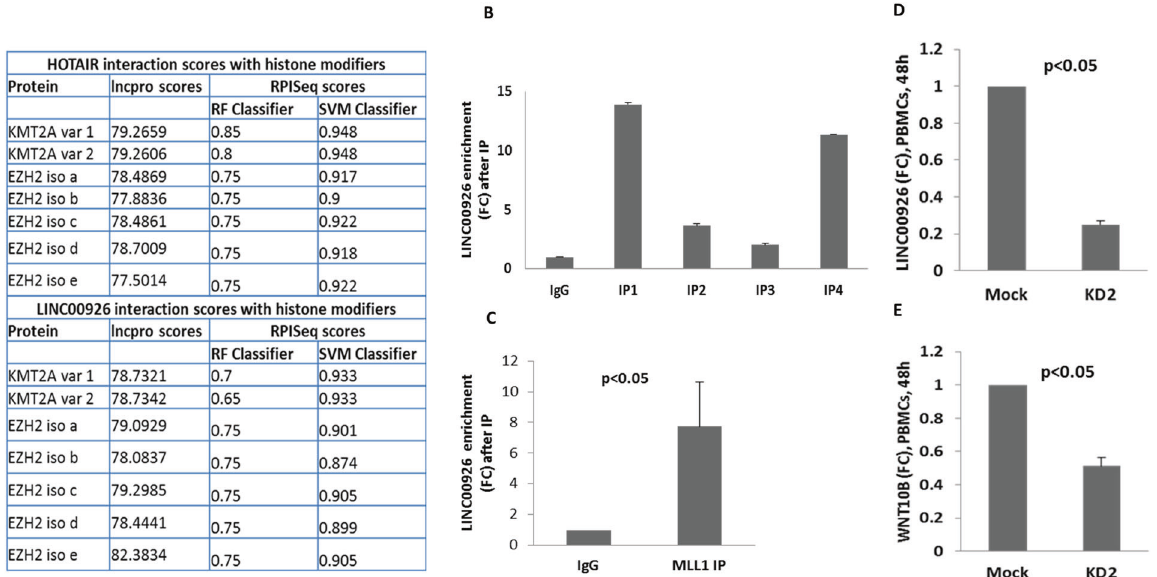
Fig. 2 LINC00926-MLL1 interaction in order to regulate WNT10B expression. We predicted that LINC00926 interacted physically with MLL1 to introduce H3K4me3 around WNT10B promotor. Thus, we fi rst analyzed the RNA – protein interaction by online prediction tools, performed ChIP-qPCR and siRNA-based knockdown to see the effect on WNT10B expression. A provides the predicted interaction scores for LINC00926- MLL1 and HOTAIR-EZH2 from the analysis tools. Following this, four separate co-immunoprecipitation using Ab against MLL1 to pull down LINC00926 and qRT-PCR to detect its enrichment was performed on whole cell extract from fi xed and crosslinked PBMCs from healthy control to show that these two molecules are physically associated ( B ). C provides the mean of the four co-immunoprecipitations. Then, in order to show that LINC00926 in fl uenced the expression of WNT10B, we knocked down LINC00926 in PBMCs by employing siRNA and measured the WNT10B transcripts by qRT-PCR ( D , E ). Each dot represents a human